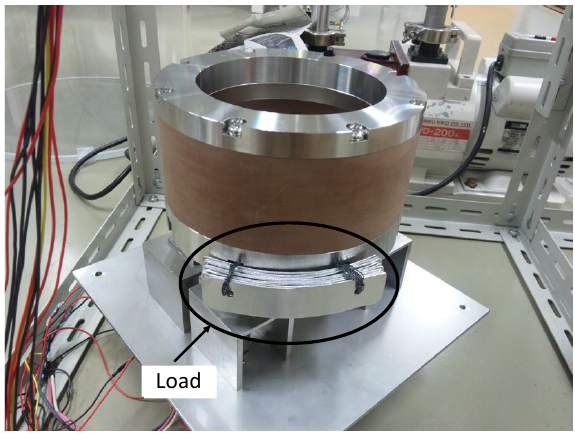
Figure 15. Rotor attached with a load of 100 g.